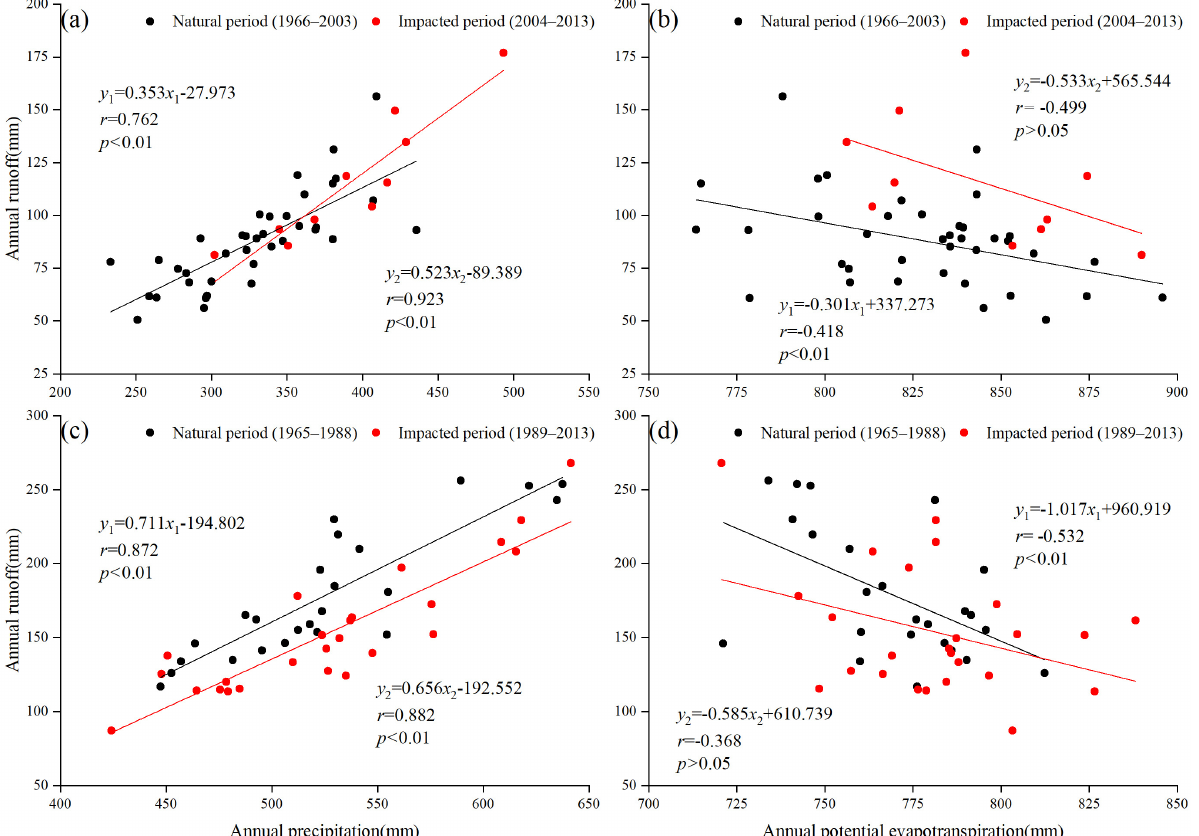
Figure 5. Correlation analysis of precipitation and potential evapotranspiration versus runoff dur- ing the natural and impacted periods in the SRYZ ( a , b ) and SRYR ( c , d ) ( r represents the correlation coefficient; p is the corresponding significance level; black and red represent the natural period and impacted period, respectively).